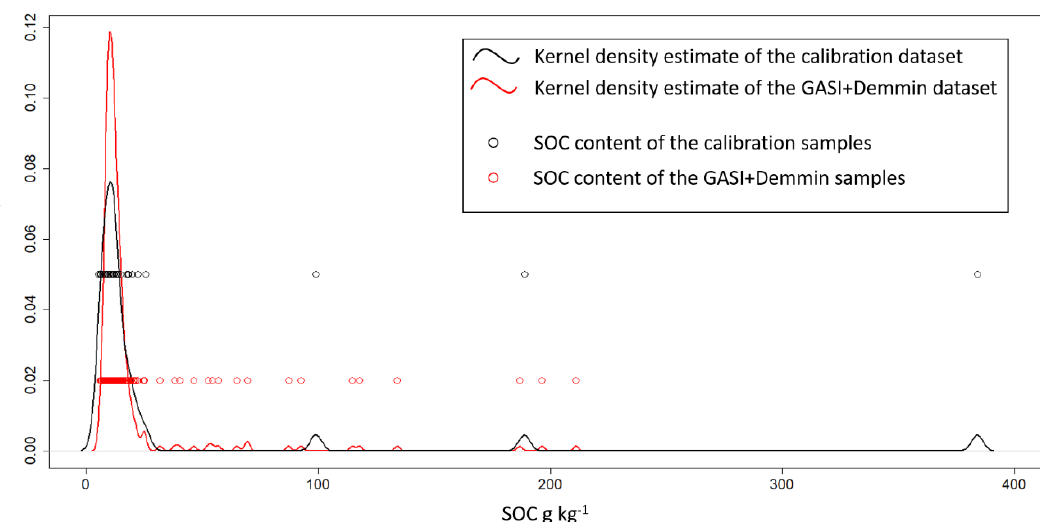
Figure 3. Kernel density estimate plot for the measured Soil Organic Carbon (SOC) values of the calibration ( black line ) and GASI + Demmin ( red line ) datasets. The black and red circles represent, respectively, the SOC content of the calibration and GASI + Demmin samples. Their position along the Y-axis was chosen only for visualization purposes.